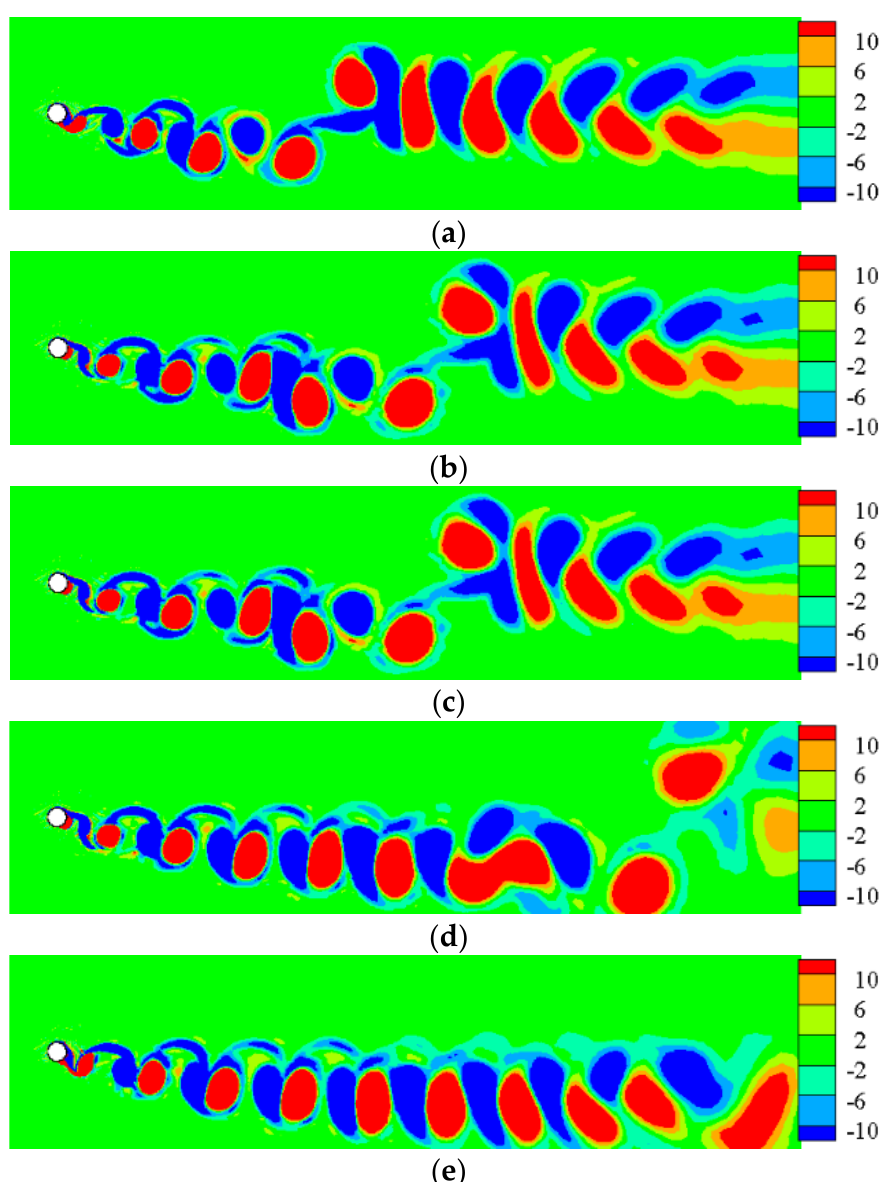
Figure 8. The vorticity contours of TWW cylinder with “Upstream” propagation. ( a ) t = 2.16 s. ( b ) t = 2.31 s. ( c ) t = 2.46 s. ( d ) t = 2.61 s. ( e ) t = 2.97 s.